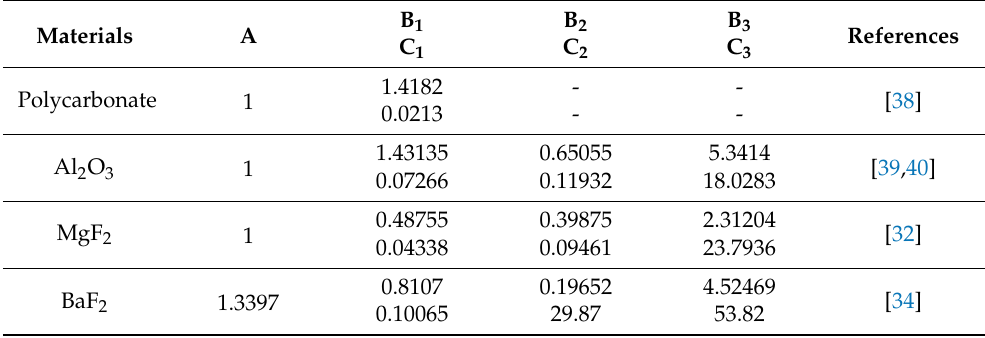
Table 1. Sellmeier coefficients of polycarbonate, Al 2 O 3 , MgF 2 and BaF 2 materials used in the proposed 1D ternary photonic designs, PC 1 to PC 3